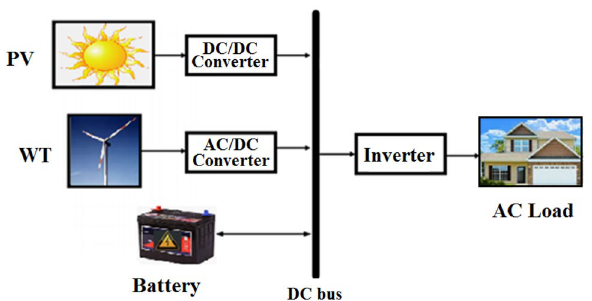
Fig. 1 Schematic of hybrid PV/WT/Batt renewable